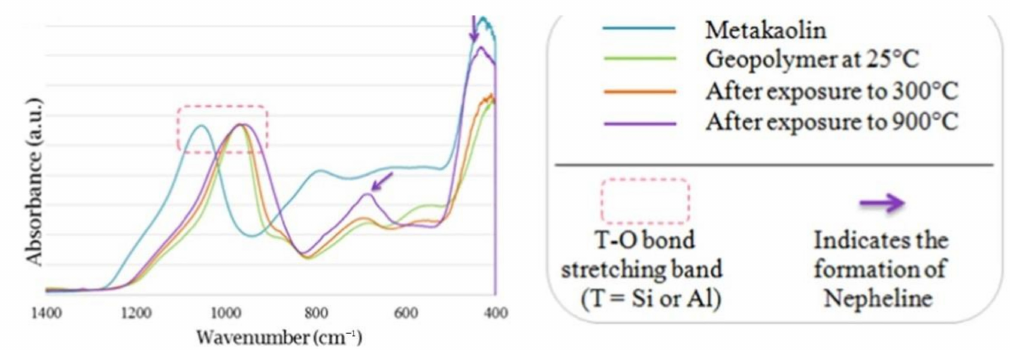
Figure 7. FTIR analysis of geopolymers before and after fire exposure [108].